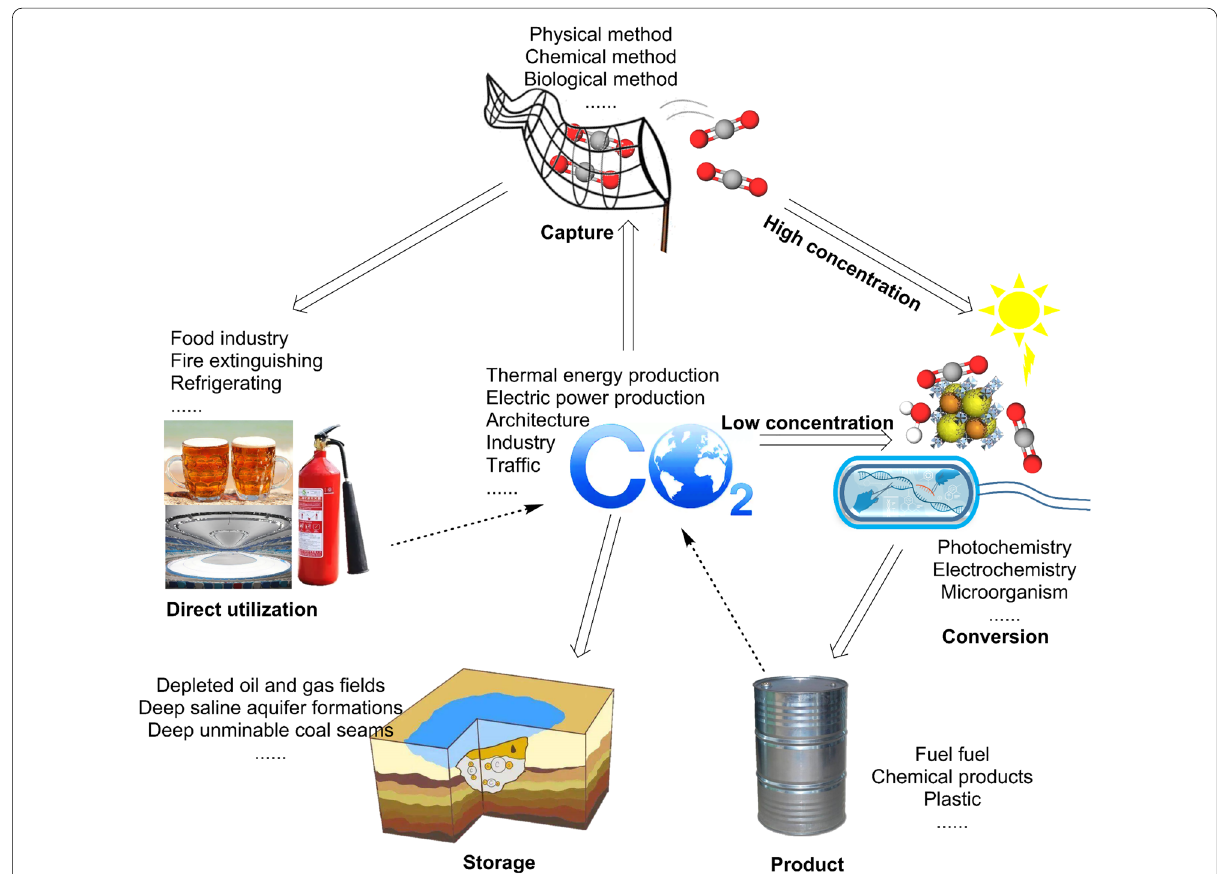
Fig. 1 Conceptual map of capture, utilization and storage of CO